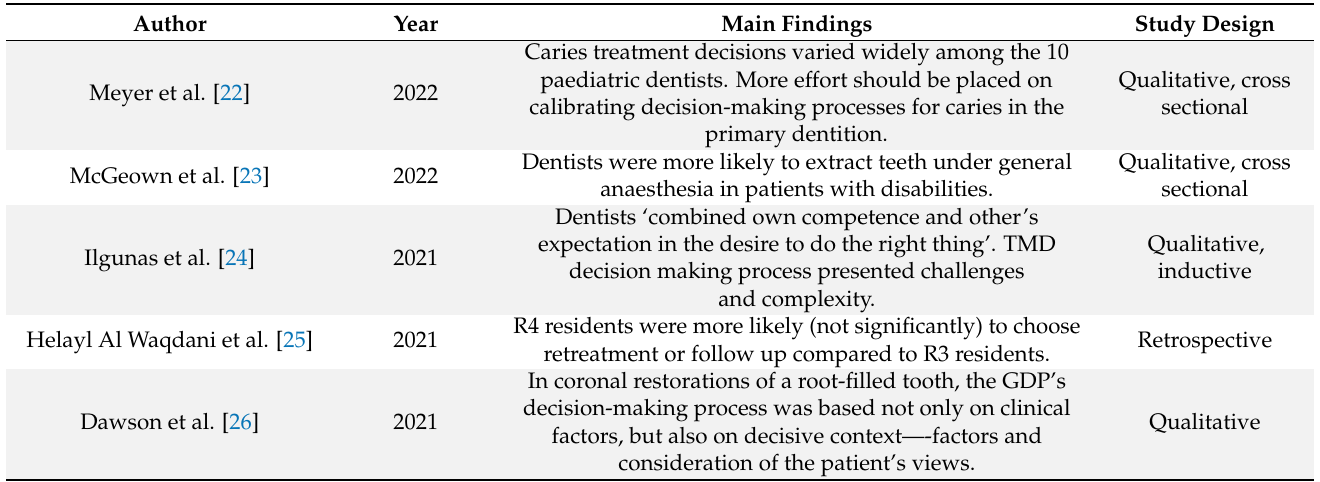
Table 1. Extracted articles that investigated heuristics and biases related to the decision- making